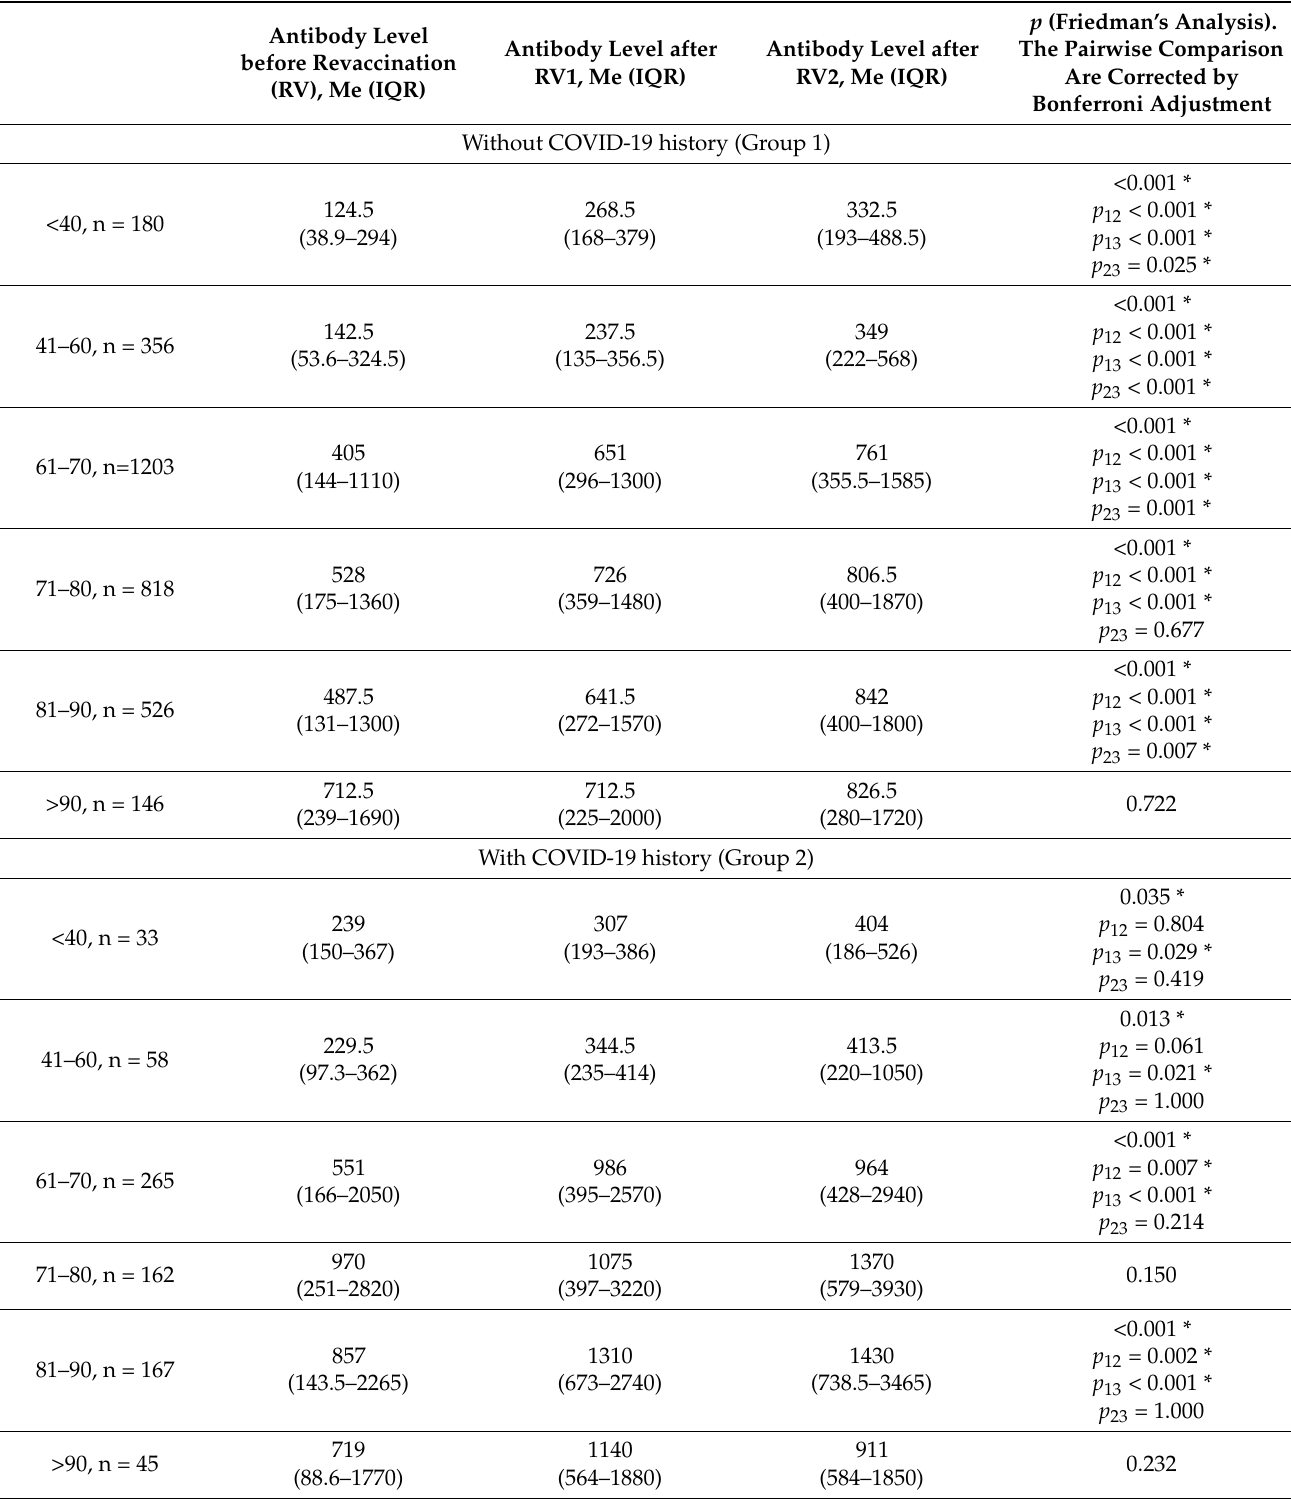
Table 2. Immunological effectiveness of revaccination with Sputnik V six months after primary vaccination with Sputnik V, depending on COVID-19 anamnesis and